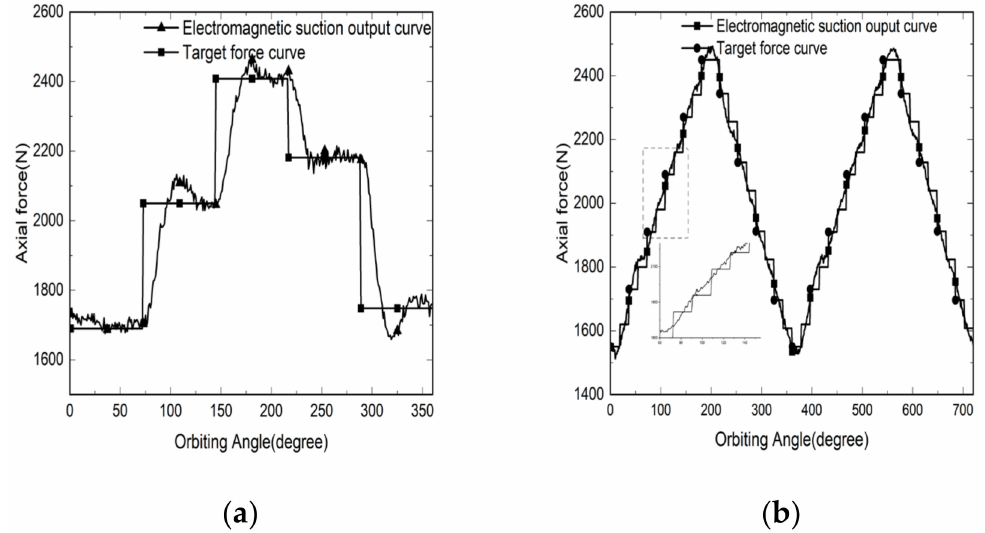
Figure 11. Electromagnetic suction tracking under different partition numbers: ( a ) the number of probe trace zones is 5; ( b ) the number of probe trace zones is